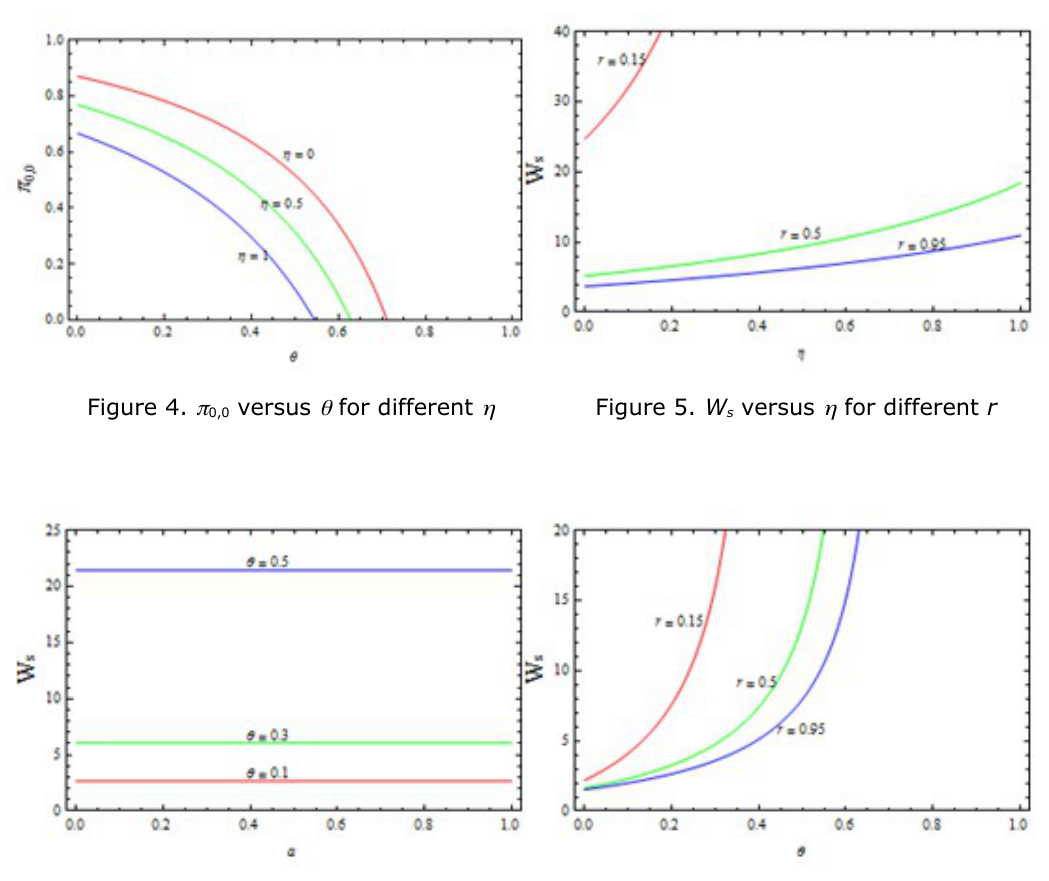
Figure 6. W s versus a for different q Figure 7. W s versus q for different